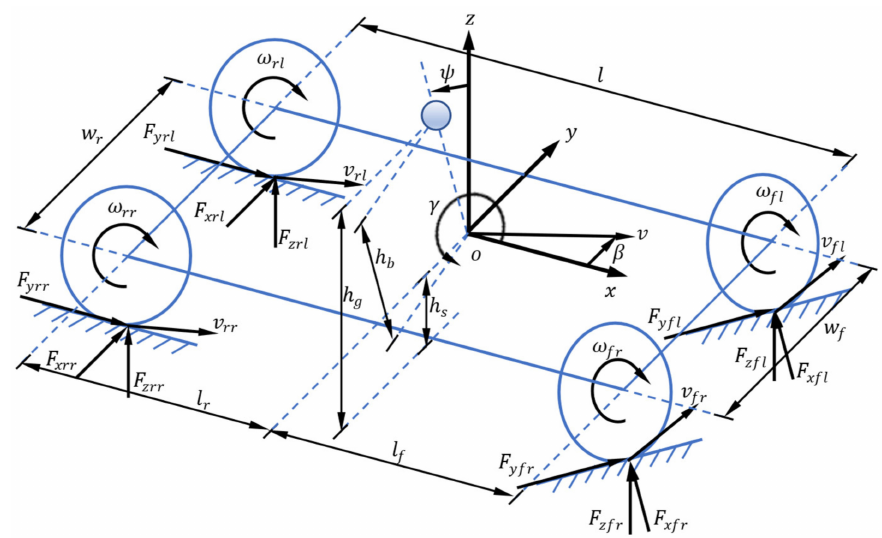
Figure 2. The vehicle dynamics